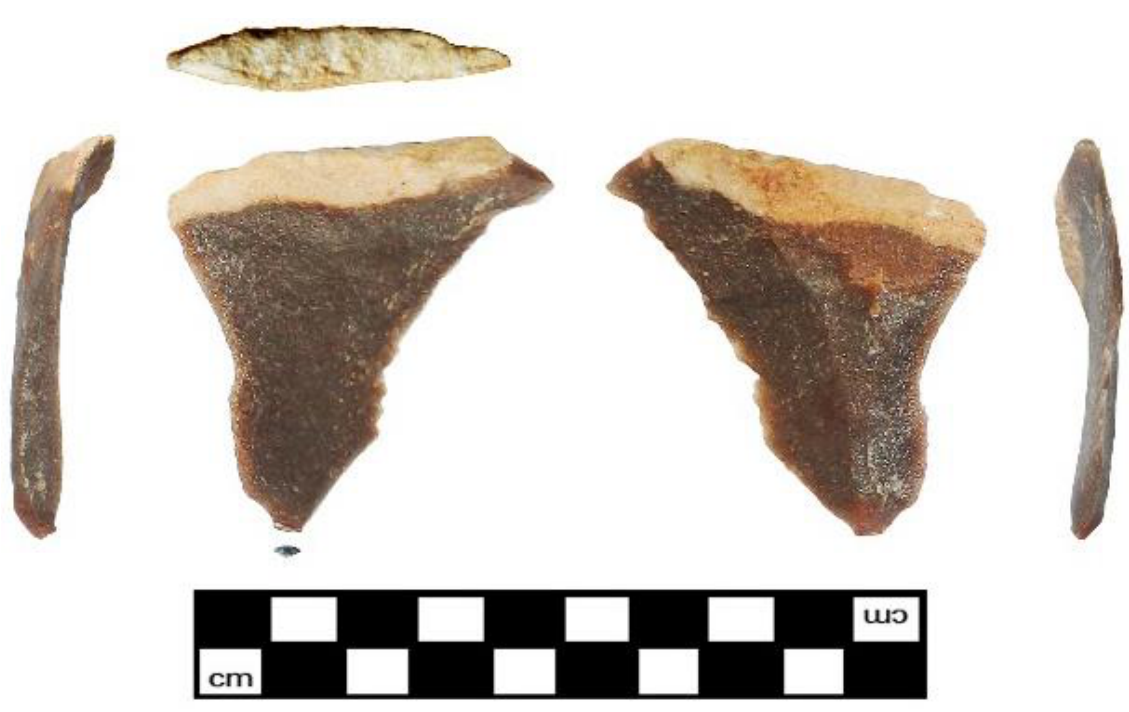
Figure 2. Replica 1 biface overshot